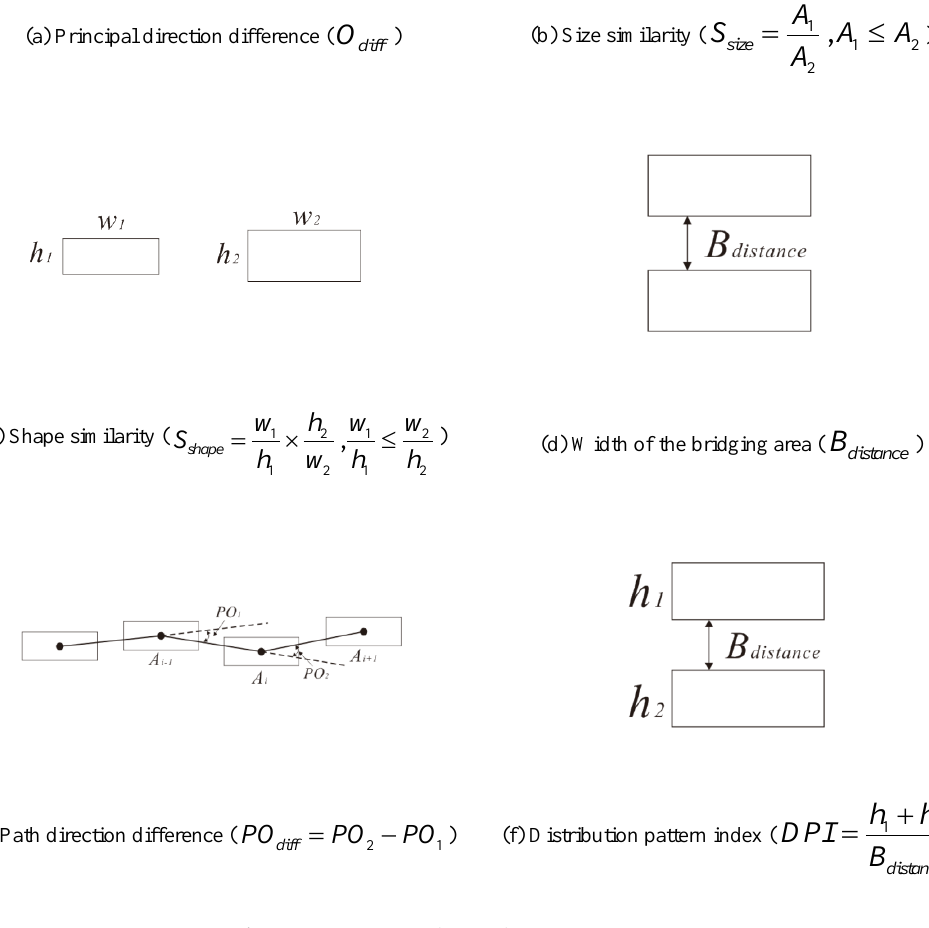
Figure 4. Description factors for the spatial structure.